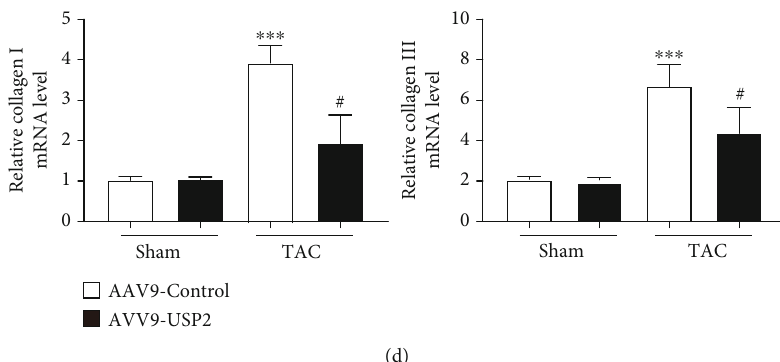
Figure 4: Overexpression of USP2 attenuated pressure overload-induced cardiac fi brosis and in fl ammation. (a) Representative images of H&E staining in the ventricular sections from AAV-Control or AAV-USP2-treated mice following sham or TAC (upper). Representative images of immuno fl uorescence staining in ventricular sections with CD68 antibody (lower). Quanti fi cation of CD68-positive cell areas (right panel). (b) mRNA levels of IL-1 β , IL-6, and MCP-1 in the hearts from AAV-Control or AAV-USP2-treated mice following sham or TAC. (c) Representative images of Masson staining in the ventricular sections, showing myocardial fi brosis, and the quanti fi cation of the relative fi brotic area. (d) mRNA levels of collagen I and collagen III in heart sections. All values are presented as the relative value of the sham (AAV9-Control) value. ∗ P < 0 : 05 and ∗∗ P < 0 : 01 (AAV9-Control plus TAC vs. AAV9-Control plus sham); # P < 0 : 05 and ## P < 0 : 01 (AAV9-Control plus TAC vs . AAV9-USP2 plus TAC). n = 6 /group.